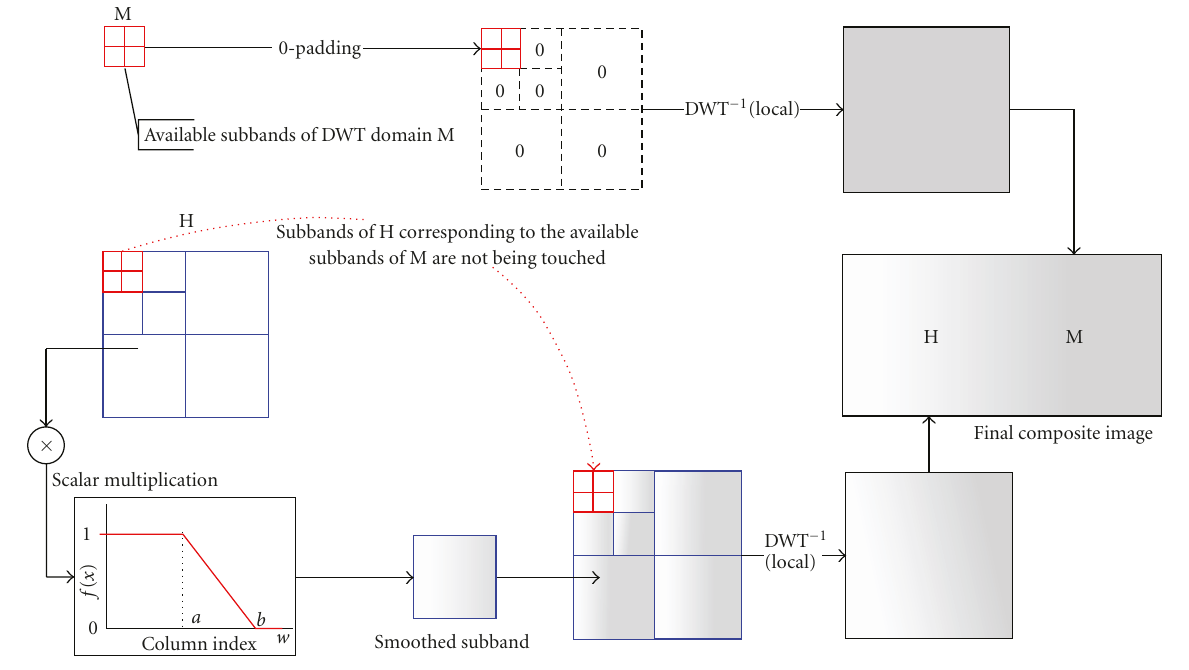
Figure 5: Example horizontal smoothing strategy in one direction (right).